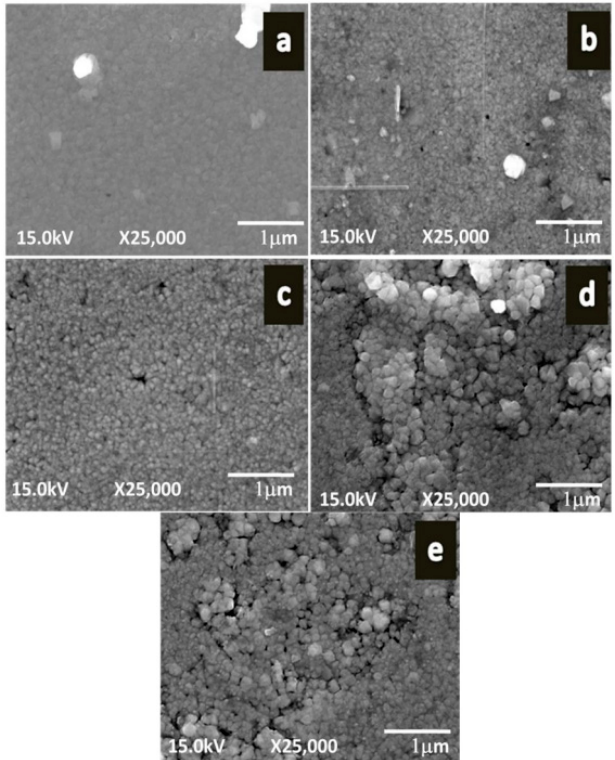
Figure 4. FESEM micrographs of PbS films deposited under various precursor concentrations ( a ) 0.1 M, ( b ) 0.15 M, ( c ) 0.2 M, ( d ) 0.25 M, ( e ) 0.3 M at 25,000 magnifications reproduced with permission from [86], Materials Science-Poland, 2016.